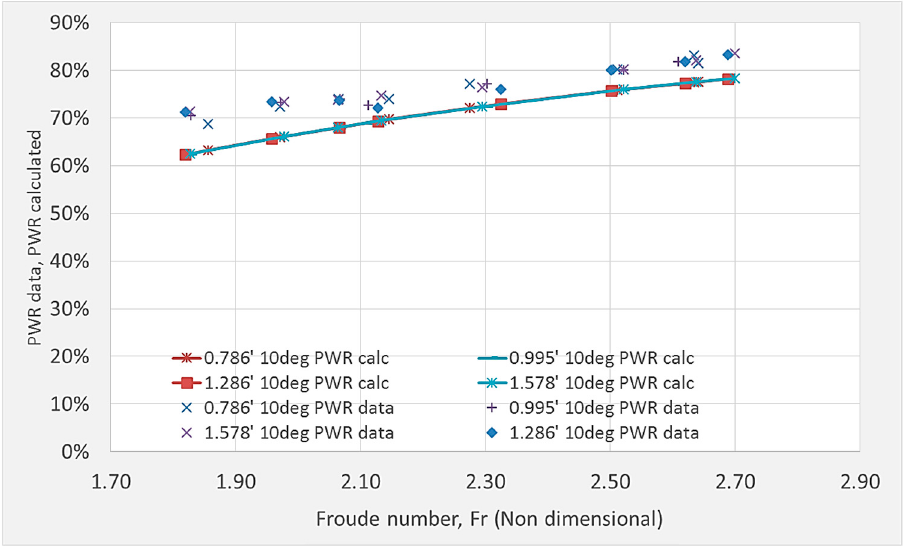
Figure 23. PWR data and PWR calc vs. Froude number (F r ), bulbous pier with 10° pitch angle.